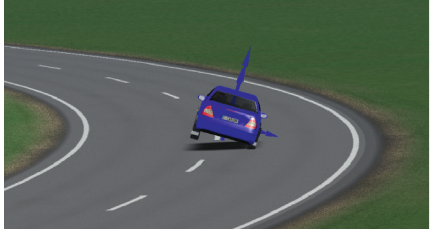
Figure 7: Lateral force coefficients of the vehicle at different positions.